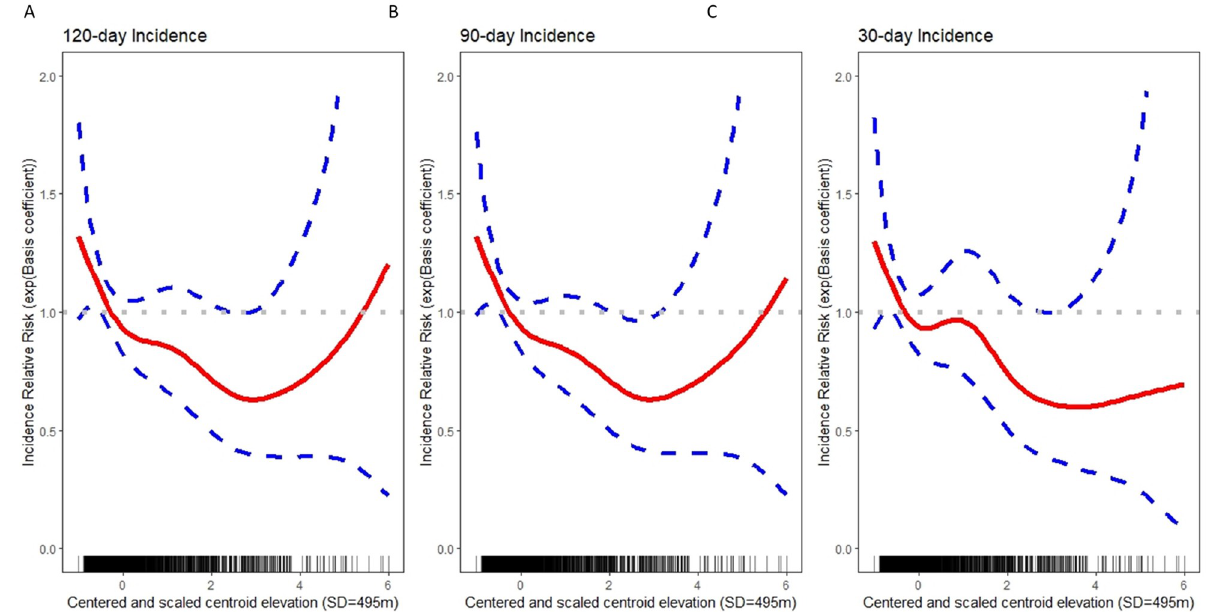
Fig 3. U.S. county-level regression models, with incident COVID-19 cases as the outcome. A) 120-day incidence decreased by 11.72% (16.07%, 7.14%) on average, B) 90-day incidence by 12.01% (16.10%, 7.72%) on average, and C) 30-day incidence decreased by 12.82% (17.18%, 8.23) on average per 495 meters of elevation on average, after adjustment for